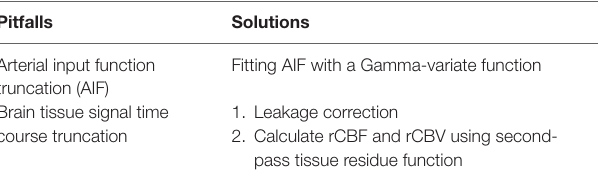
TaBle 1 | summary of technical pitfalls and potential